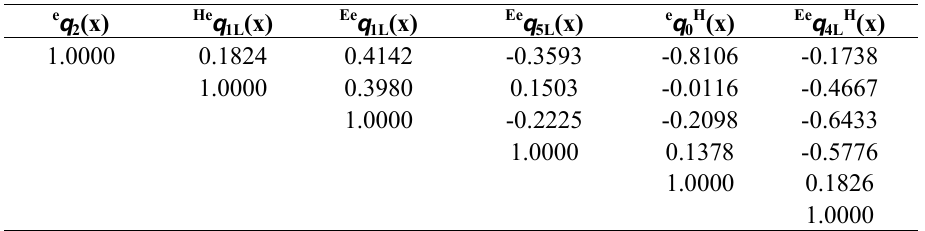
Table 16. The squared correlation matrix showing covariance (r 2 ) among the topological descriptors (Total and local quadratic indices) used in the regression analysis for 70 compounds.